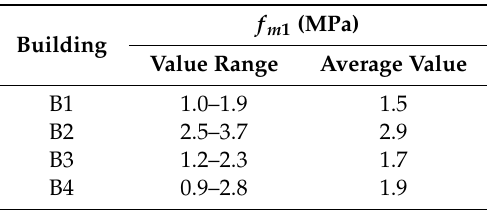
Figure 8. Relation between mortar compressive strength ( f m 1 ) and depth penetration after 10 impacts ( ∆ d p (10) )—correlation curve according to [34]. Table 5. The mortar compressive strength ( f m 1 ) determined based on the penetrometer test results according to the correlation curve from [34].